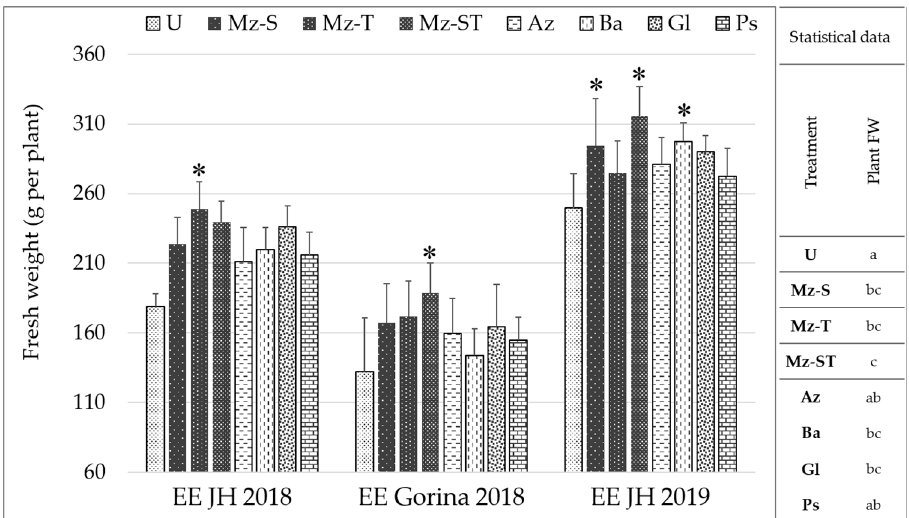
Figure 7. Lettuce yield of plants grown in productive greenhouse conditions. In the figure, average of lettuce plants fresh weight (FW) at commercial harvest of plants in each experimental station are plotted. Asterisks above the bar indicate significant differences with respect to the U treatment in each individual trial at p ≤ 0.05 according to Tukey’s test. Different letters in the statistical data (on the right) indicate significant differences ( p ≤ 0.05) according to Tukey’s test. Mz-S: multispecies at